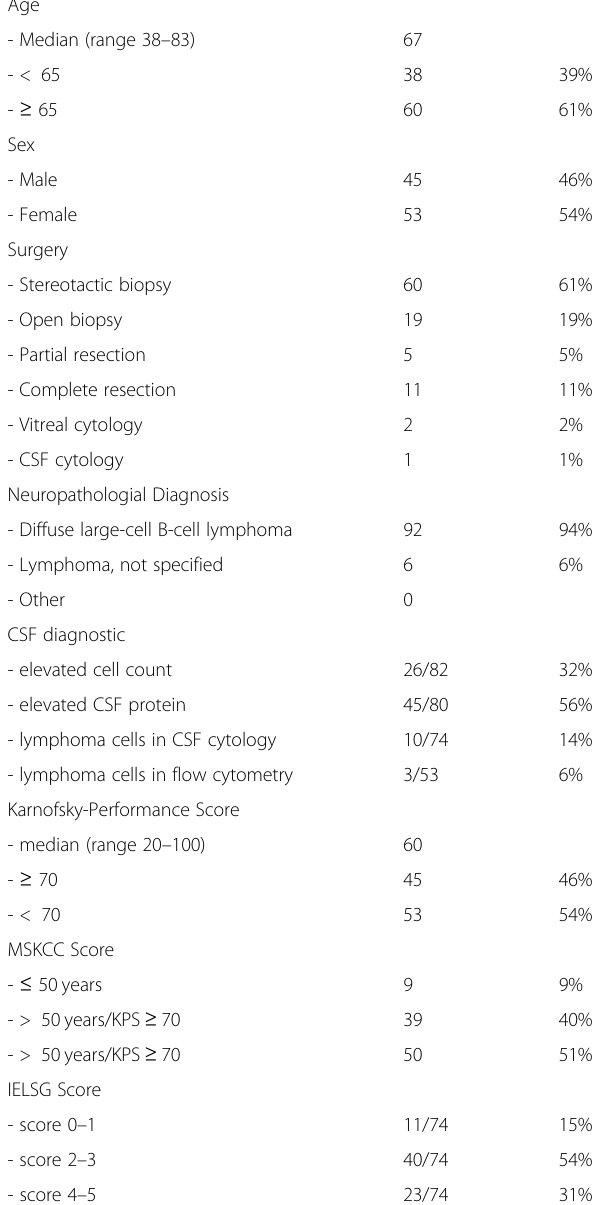
Table 2 Pretherapeutic patients`